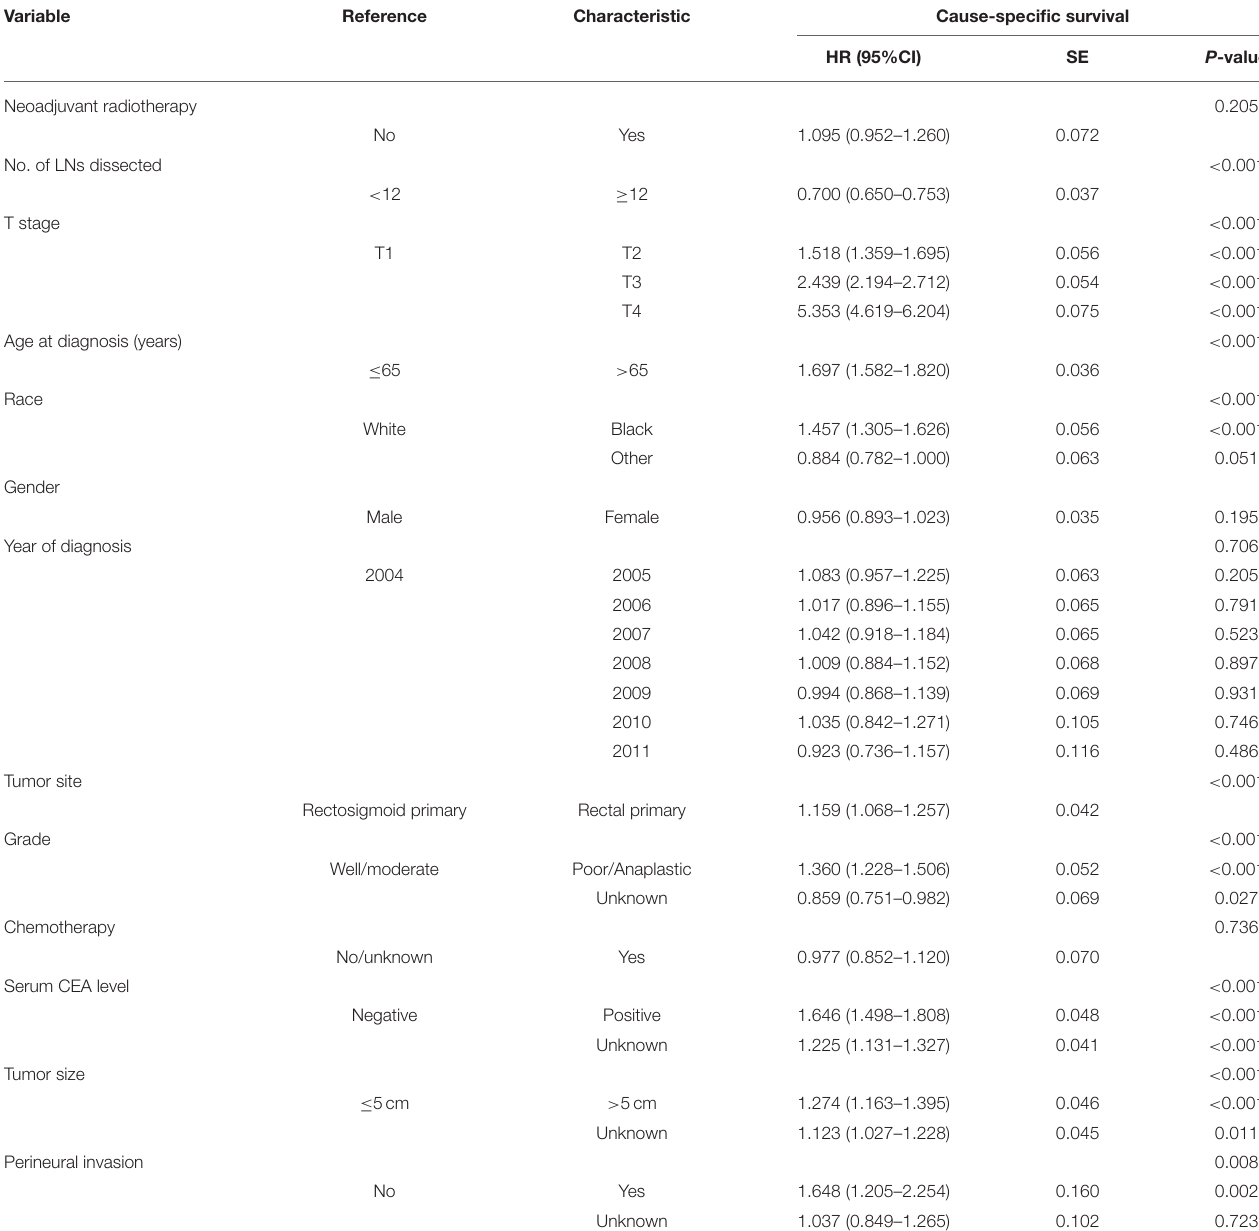
TABLE 2 | Multivariate Cox regression analyses of the clinicopathological characteristics concerning